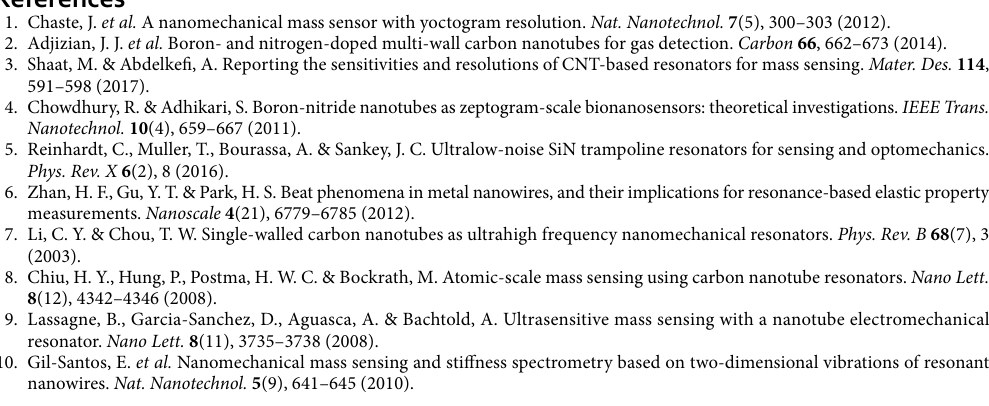
/ps and 84.7 /ps. ( d ) Damping factors of Å Å